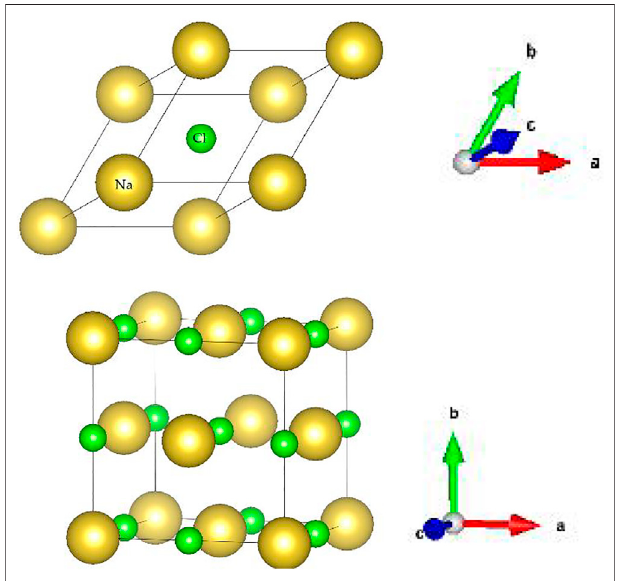
FIGURE 1 | (Upper) primitive cell and (Bottom) unit cell of NaCl material.